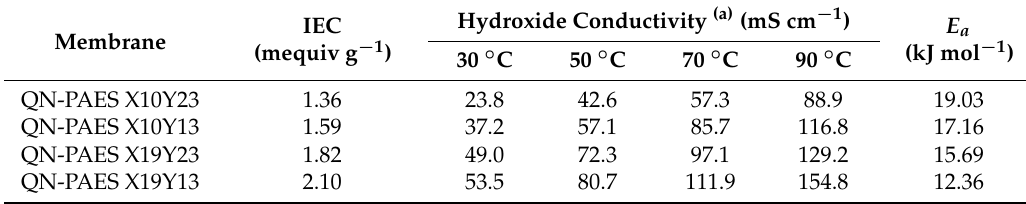
Table 4. IEC, hydroxide conductivity, and activation energy ( E a ) of QN-PAES membranes.